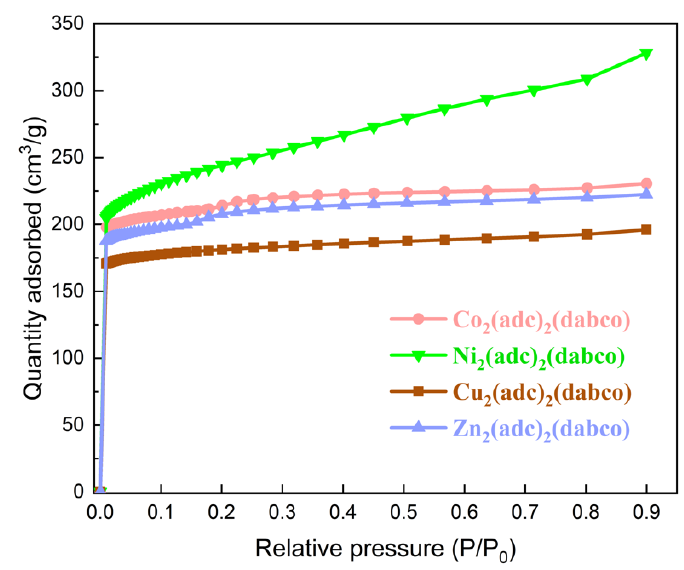
Figure 2. The isotherms of nitrogen adsorption in MOFs[M 2 (adc) 2 (dabco)] (M = Co, Ni, Cu, Zn) at − 196 °C. Table 1. A summary of textural properties of MOFs [M 2 (adc) 2 (dabco)] (M = Co, Ni, Cu,